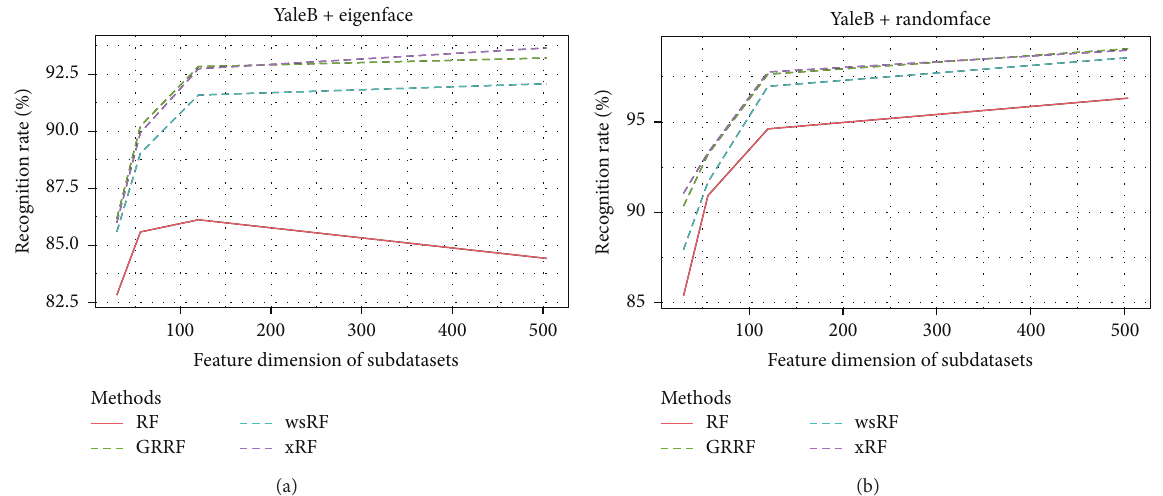
Figure 1: Recognition rates of the models on the YaleB subdatasets, namely, YaleB.EigenfaceM30, YaleB.EigenfaceM56, YaleB.EigenfaceM120, YaleB.EigenfaceM504, and YaleB.RandomfaceM30, YaleB.RandomfaceM56, YaleB.RandomfaceM120, and YaleB.RandomfaceM504.